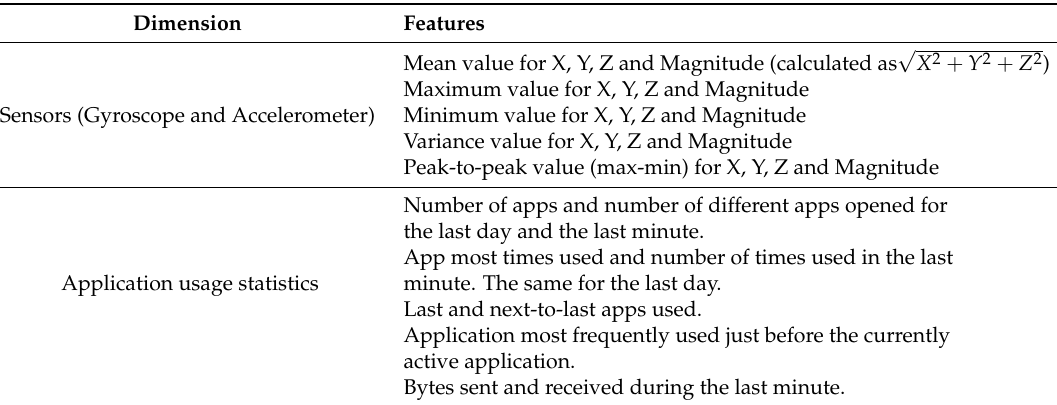
Table 1. Final features selected for each